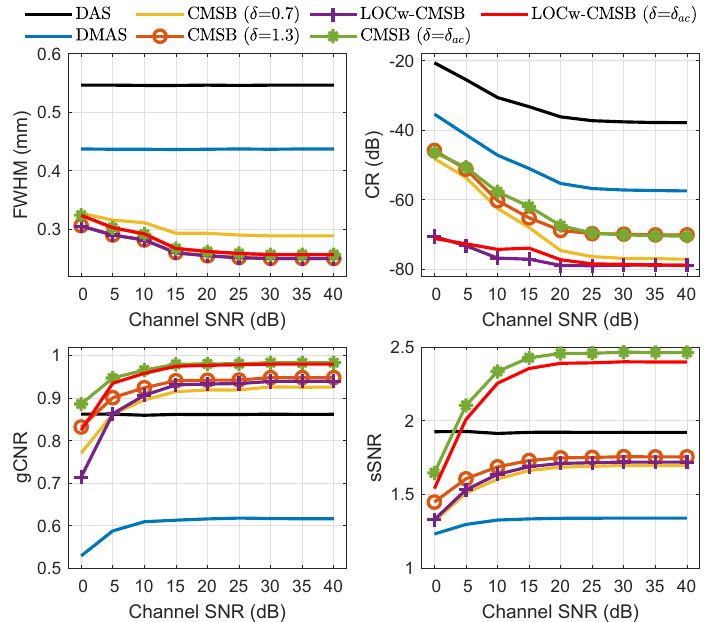
Figure 9. Full-width and half-maximum (FWHM), contrast ratio (CR), generalized contrast-to-noise ratio (gCNR), and speckle signal-to-noise ratio (sSNR) of all methods under different channel SNRs in the